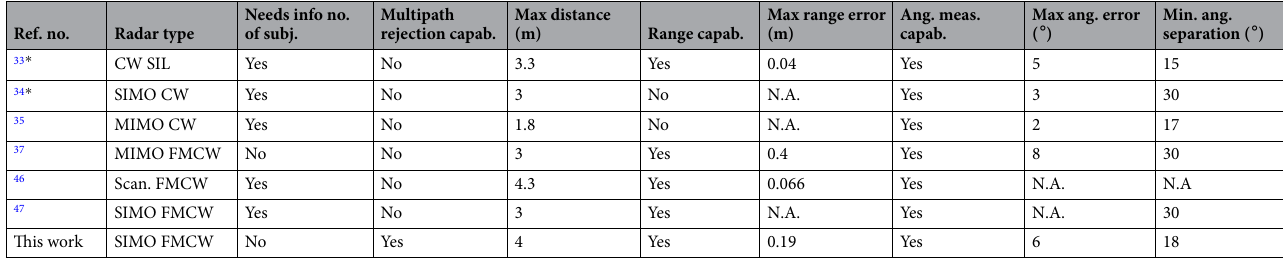
Table 3. Performance comparison of this work with alternative state-of-the-art radars.